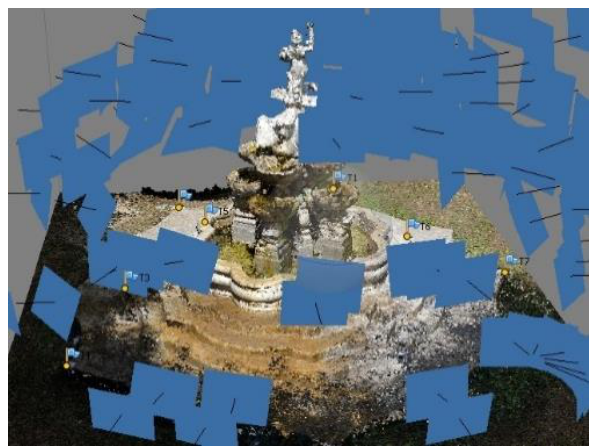
Figure 6. The photogrammetric reconstruction of the Garraffo fountain.